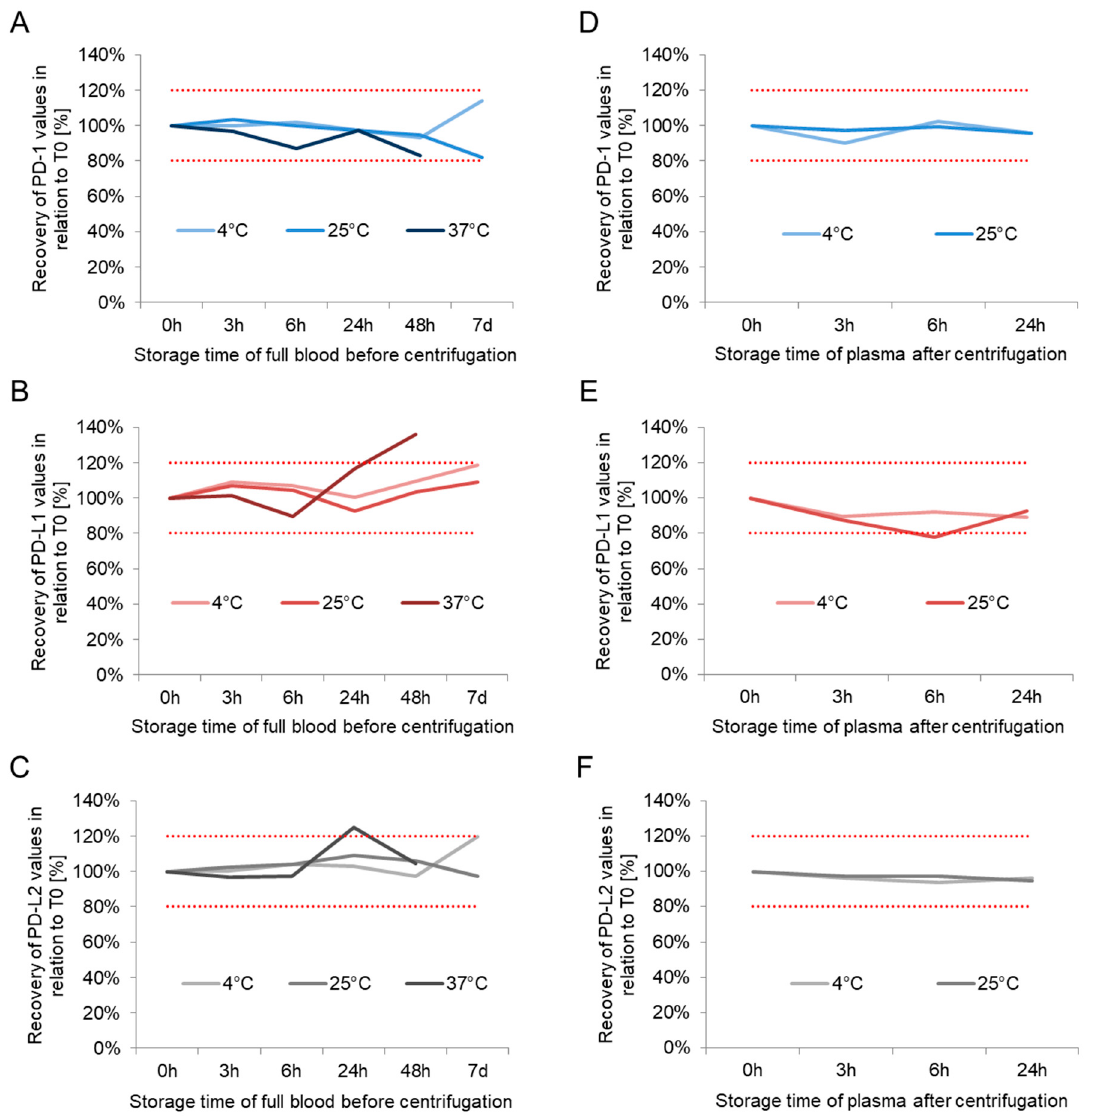
Figure 3. Short-term stability results before and after centrifugation. Mean recoveries obtained in the short-term stability experiment were measured in nine different heparin plasma samples. PD 1, PD L1, and PD L2 results of the whole blood samples are visualized in the left part of the figure ( A , C , E ) and those of the plasma in the right part ( B , D , F ). For clarity, coefficients of variations are provided in Table 1 The blue lines represent before centrifugation results meanwhile the pink ones encompass all after centrifugation results. Dotted red lines mark the 80% and 120% borders.